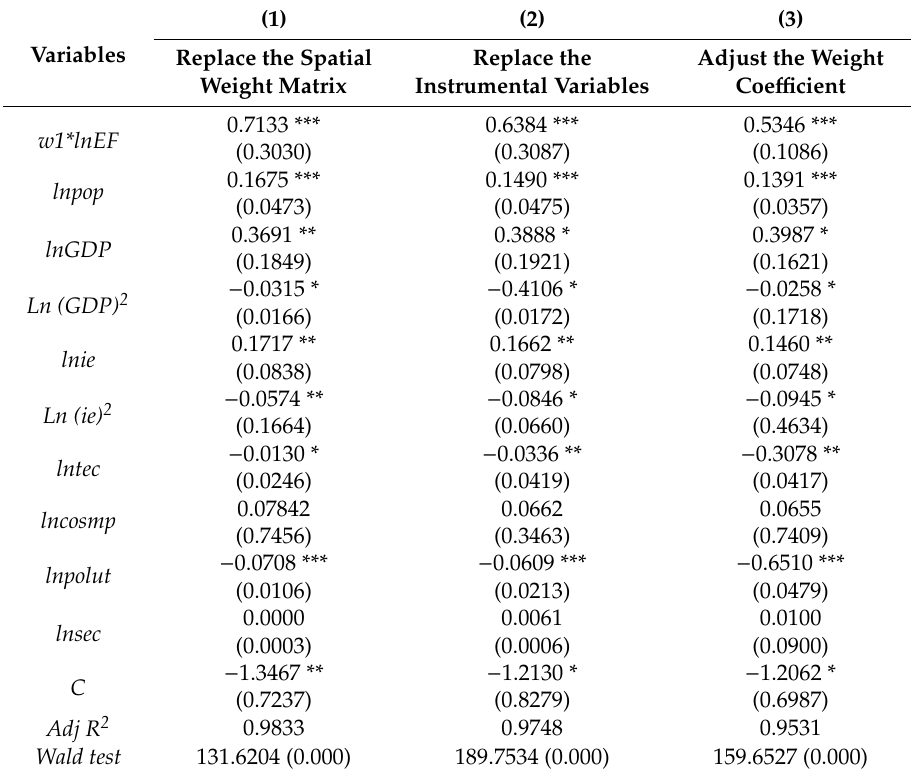
Table 3. Robustness test